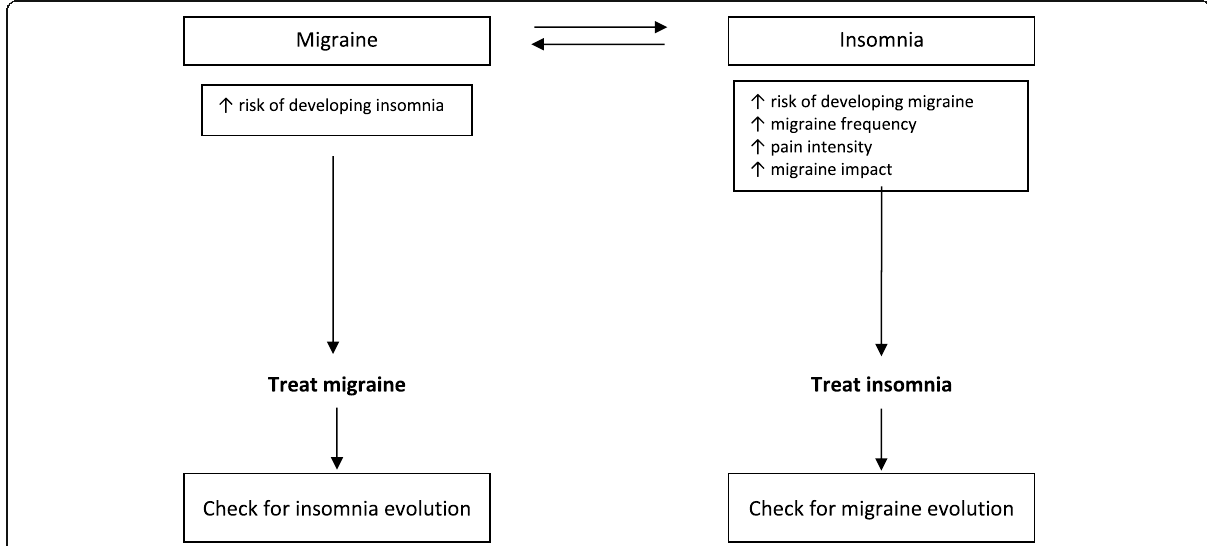
Fig. 2 Interaction between migraine and insomnia. Available evidence suggests the existence of a bidirectional association between migraine and insomnia that is independent from anxiety and depression. Migraine patients are at increased risk of developing insomnia, and insomnia is a risk factor for migraine onset and for increased migraine impact, pain intensity, and chronification. Routine evaluation of the presence of insomnia complaints in patients with migraine and implementation of specific pharmacological and non-pharmacological insomnia treatments would be appropriate since a reduction of migraine burden might be